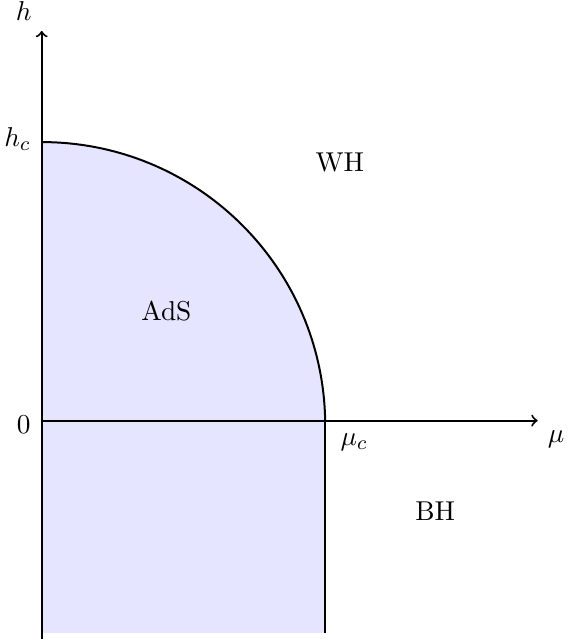
Figure 6 . Diagram that shows the ground state of the Hamiltonian (4.11) for different values of h and µ . Empty AdS is the dominant contribution at the origin up to the critical values h c = point ( h = 0 , µ = µ c ) is a triple point where the three phases meet. For negative values of h , there is a competition between the empty AdS and the black holes phases. Note that depending on the mass of the monopoles in the theory there could be a region in the diagram where the ground state is AdS with